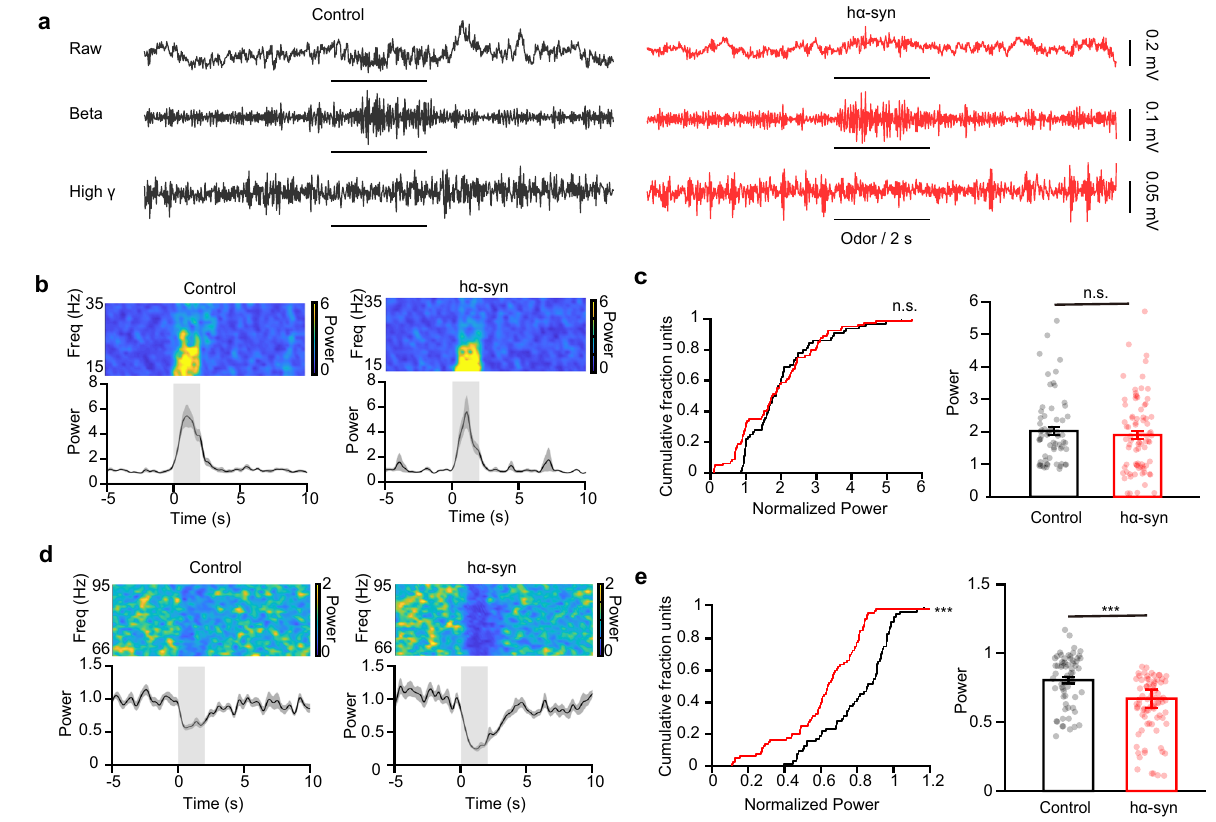
Fig. 4 α -Synuclein aggregates change the odor-evoked high-gamma response in the OB. a Examples of raw traces (top) and fi ltered beta (middle) and high-gamma (bottom) oscillations in the LFP signals recorded from representative control and h α -syn mice in vivo with odor stimulation. b , d Example power spectra (top) and trial-averaged normalized traces (bottom) of beta ( b ) and high-gamma ( d ) responses elicited by isoamyl acetate delivery (gray boxes). c , e Power in the normalized odor-evoked beta band ( c ) and high-gamma band ( d ) in the two groups (odor – mouse pair: n = 64 for the control group; n = 80 for the h α -syn group). *** p < 0.001; n.s. not signi fi cant. Data are presented as mean ± the control and h α -Syn groups, respectively. The distribution of fi ring rates is shown in Fig. 3c. Compared with the control group, spontaneous fi ring of M/Ts was signi fi cantly greater in the h α -syn group (Fig. 3c, two sample K-S test, Z = 0.23, p = 0.04 and Fig. 3d,